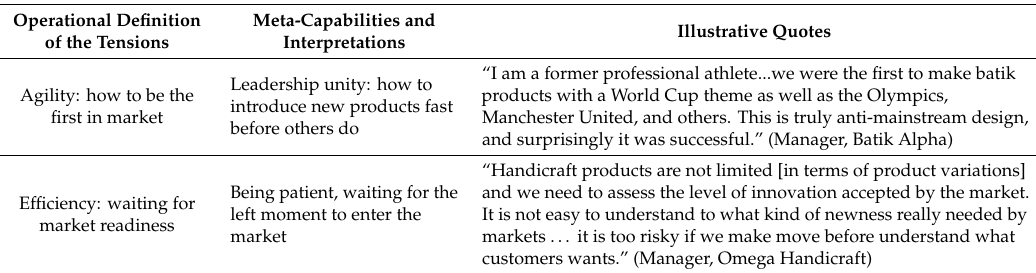
Table 3. First in the market or waiting for market